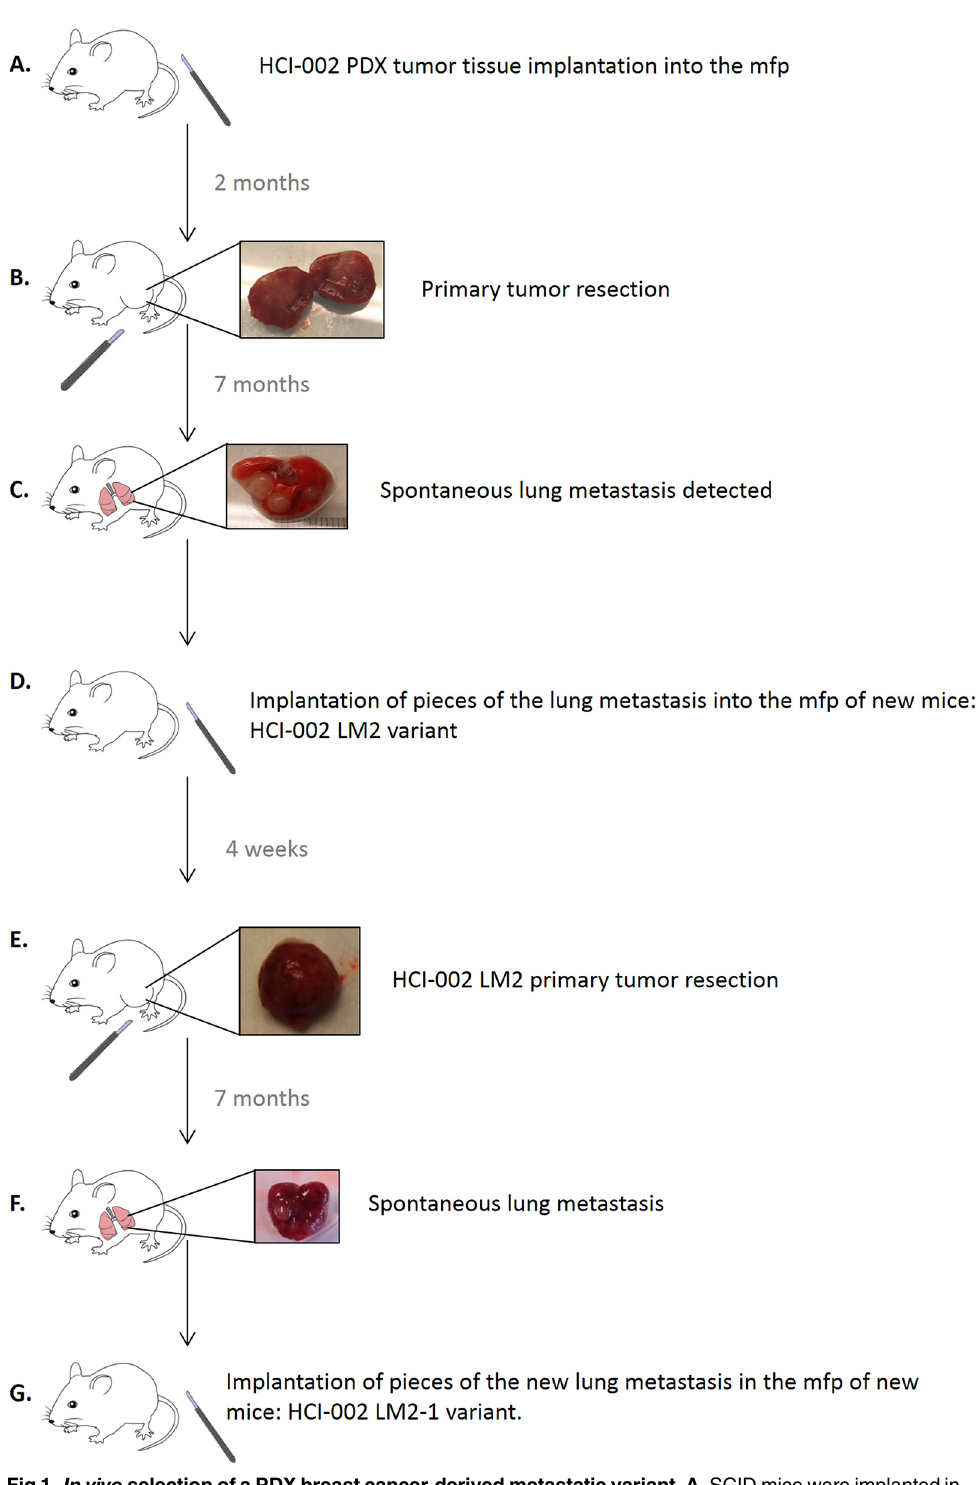
Fig 1. In vivo selection of a PDX breast cancer-derived metastatic variant. A. SCID mice were implanted in the mammary fat pad (mfp) with tumor fragments of the triple negative breast cancer PDX tumor HCI-002. B. Two months later, primary tumors were resected. C. After 7 months, one mouse developed on overt lung metastasis that was positive for the Human Leukocyte Antigen (HLA). D. Fragments of this lung metastasis were implanted in the mammary fat pads (mfp) of naive SCID mice and the variant called HCI-002 ML2 was isolated. This new